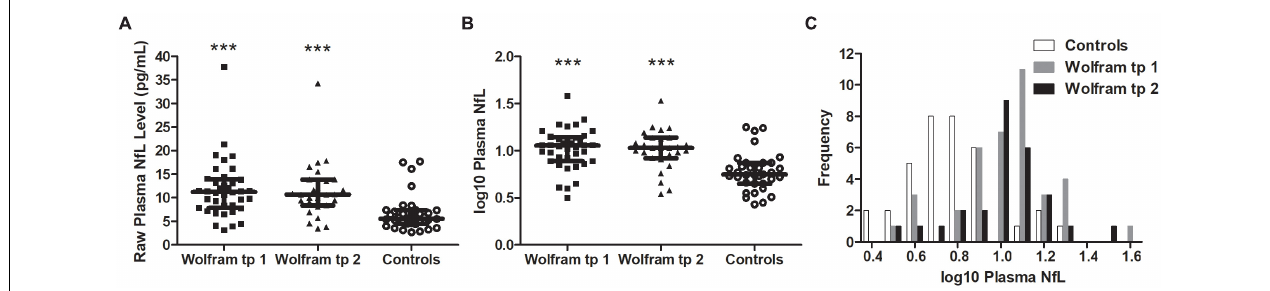
FIGURE 1 | Raw (A) and log10 (B) plasma NfL levels were higher in the Wolfram group at time points 1 and 2 relative to controls. Results were similar when outlier data were excluded. Median and IQR shown. (C) Frequency distribution of log10 plasma NfL levels for control and Wolfram groups at time points 1 and 2. NfL,